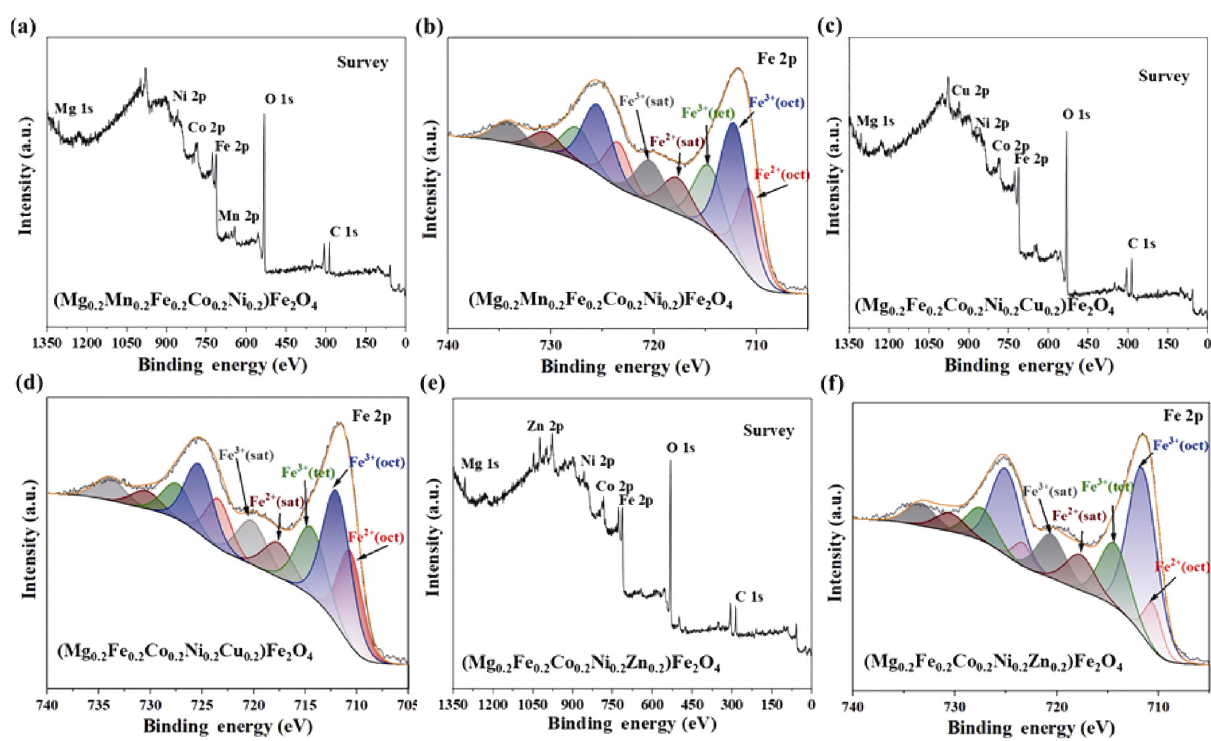
Fig. 2 (a) XPS survey and (b) Fe 2p XPS results of HE MFe 2 O 4